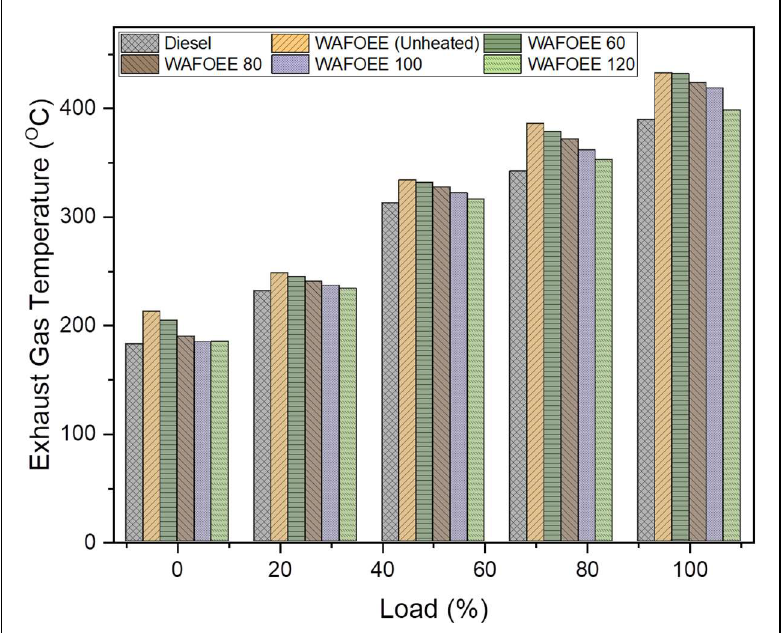
Figure 8. Exhaust gas temperature of neat diesel and biodiesel samples for varying engine loads.